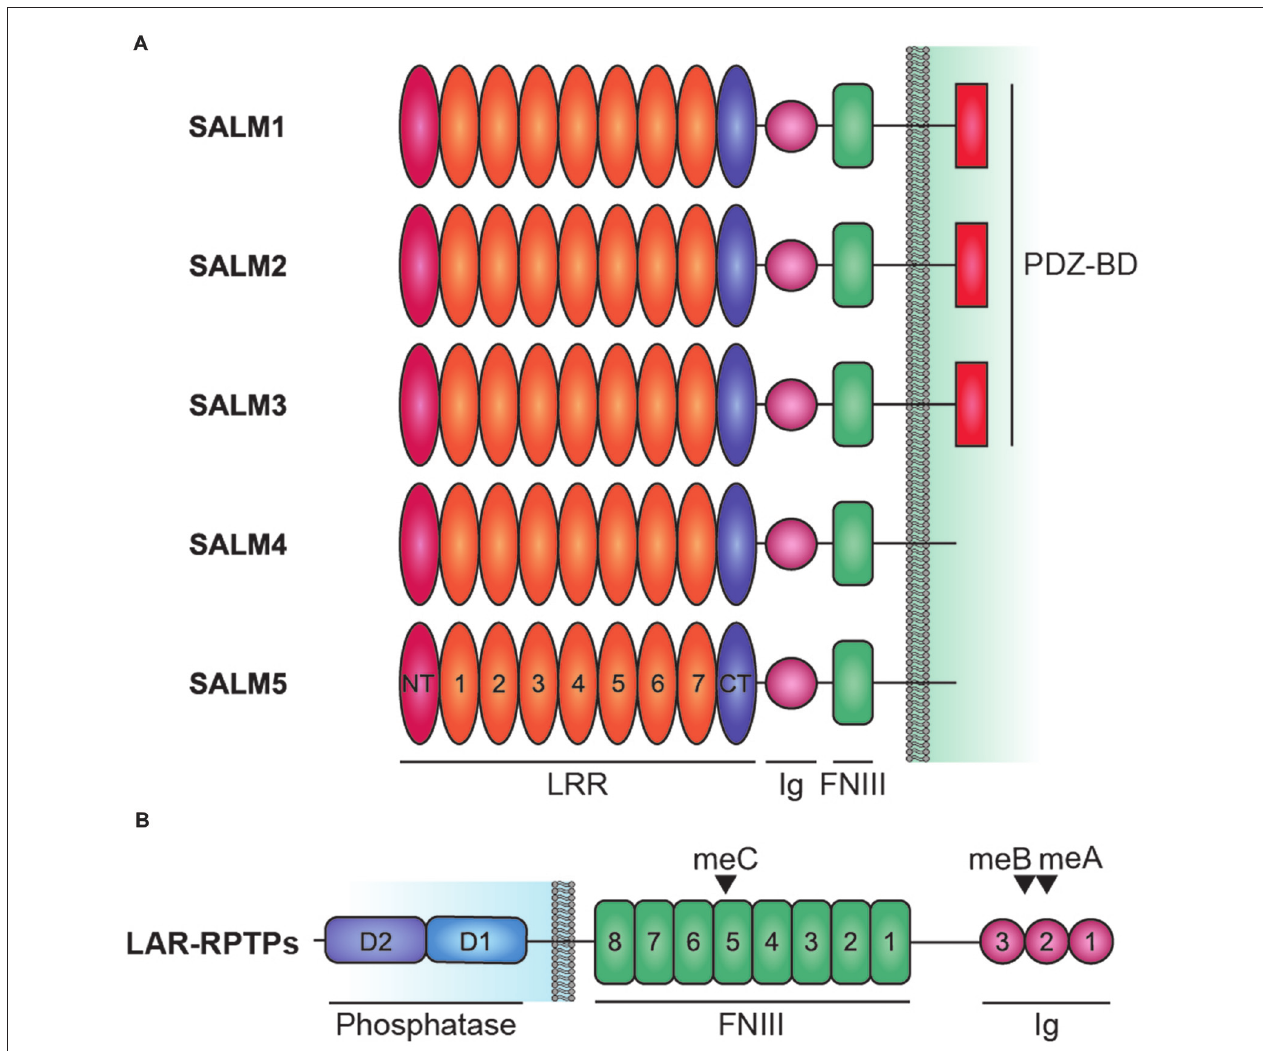
FIGURE 1 | Domain structure of Synaptic adhesion-like molecules (SALMs) and LAR-RPTPs. (A) Domain structure of SALMs 1–5. Note that the PDZ domain-binding motif (PDZ-BD) is present in SALMs 1–3 but not in SALM4 or SALM5. FNIII, fibronectin III domain; Ig, immunoglobulin domain; LRR, leucine-rich repeats; NT and CT, N-terminal and C-terminal LRR. Note that the number of LRRs in this diagram is seven, although it was suggested to be six in early studies based on amino acid sequence analyses (Ko et al., 2006; Morimura et al., 2006; Wang et al., 2006; Nam et al., 2011). Recent X-ray crystallographic studies have identified seven LRRs in SALM5 (Lin et al., 2018) and eight LRRs in SALM2 and SALM5 (Goto-Ito et al., 2018), which may reflect different ways of defining LRRs. (B) Domain structure of LAR-RPTPs (LAR, PTP σ and PTP δ ). D1 and D2, membrane-proximal and -distal tyrosine phosphatase domains of LAR-RPTPs; meA/B/C; mini-exon A/B/C.